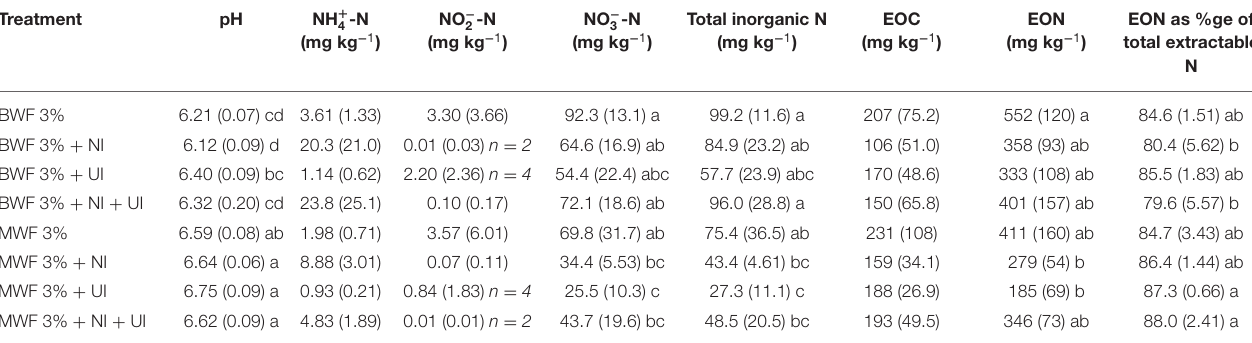
TABLE 4 | Substrate pH, ammonium (NH + 4 -N), nitrite (NO − 2 -N), nitrate (NO − 3 -N), total inorganic N, extractable organic C (EOC) and N (EON) and EON as a percentage of total extractable N, at the end of the experiment (mean ± standard deviation for n = 5 except where indicated).